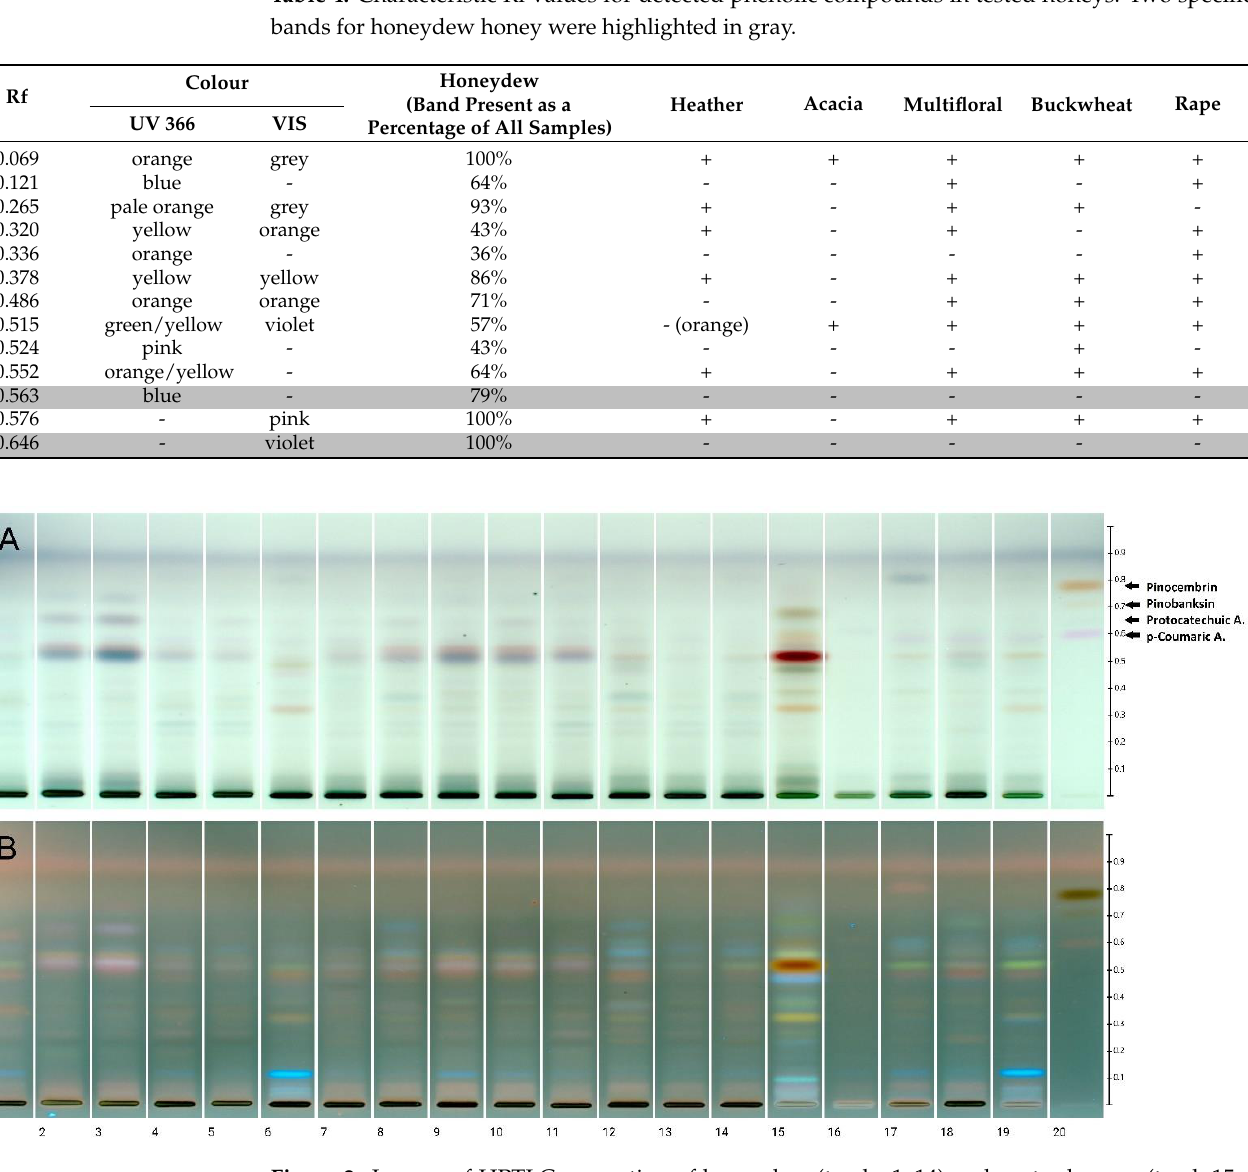
Figure 2. Images of HPTLC separation of honeydew (tracks 1–14) and nectar honeys (track 15— Figure 2 . Images of HPTLC separation of honeydew (tracks 1 – 14) and nectar honeys (track 15 — heather, 16—acacia, 17—multifloral, 18—buckwheat, 19—rape) after p-anisaldehyde derivatization, in UV 366 nm light ( A ) and visible light ( B ). Track 20 standards (in order of increasing Rf values): p-coumaric acid, protocatechuic acid, pinobanksin, Table 4. Characteristic Rf values for detected phenolic compounds in tested honeys. Two specific bands for honeydew honey were highlighted in gray.